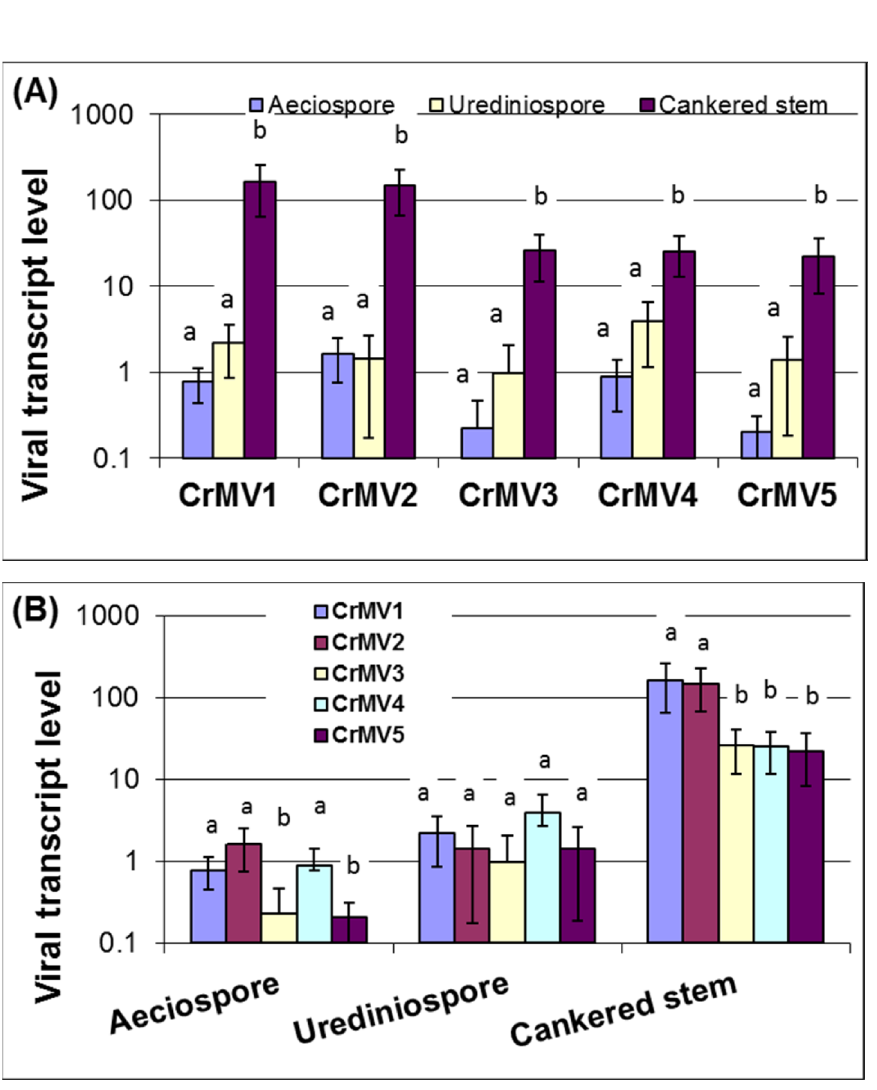
Fig 4. Genomic RNA abundance of Cronartium ribicola mitoviruses (CrMV1 to CrMV5) as measured by qRT-PCR analysis. C . ribicola tubulin transcript was used as the calibrator for normalization of input RNA levels across the 15 fungal isolates that are listed in Table 1. For each mitovirus, RNA levels in different fungal isolates were calculated according to the 2 − ΔΔ Ct algorithm using C . ribicola isolate BC-a6 as the reference. Means for relative levels of viral RNA accumulation in each type of samples are shown. Bars with different letters were significantly different using t-test ( P < 0.05). One, two, and three stars ( * ) indicate P < 0.05, P < 0.01, and P < 0.001, respectively. Four comparisons were made as: (1) avcr2 isolates (BC-a6, BC- a20, and BC-a28) vs . vcr2 isolates (OR-a1, OR-a2, and OR-a3) at the aeciospore stage; (2) avcr2 isolates (OR-sus1, OR-sus2, and OR-sus3) vs . vcr2 isolates (OR-res1, OR-res2, and OR-res3) at the mycelium growth stage inside the cankered stem; (3) avcr2 isolates at the stage of aeciospores (BC-a6, BC-a20, and BC-a28) vs . urediniospore (BC-u2a, BC-u3, and BC-u48), and vs . the stage of mycelium growth inside cankered stem (OR-sus1, OR-sus2, and OR-sus3), and different letters indicate significant differences between groups (p < 0.05); (4) vcr2 isolates at the stage of aeciospore (OR-a1, OR-a2, and OR-a3) vs . the stage of mycelium growth inside cankered stem (OR-res1, OR-res2, and OR-res3).